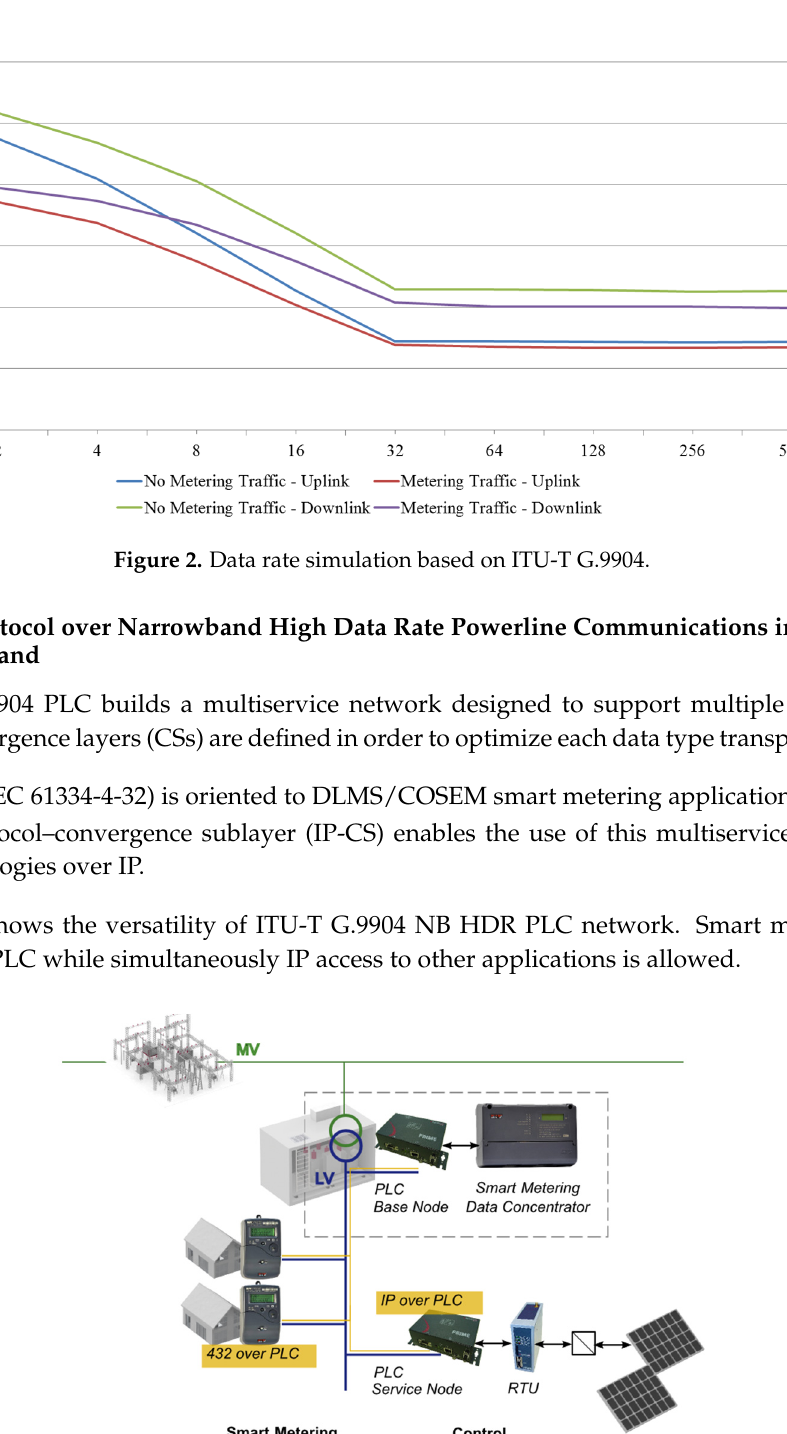
Figure 1. Frame error rate (FER) simulation based on ITU ‐ T G.9904. International telecommunication union: ITU.